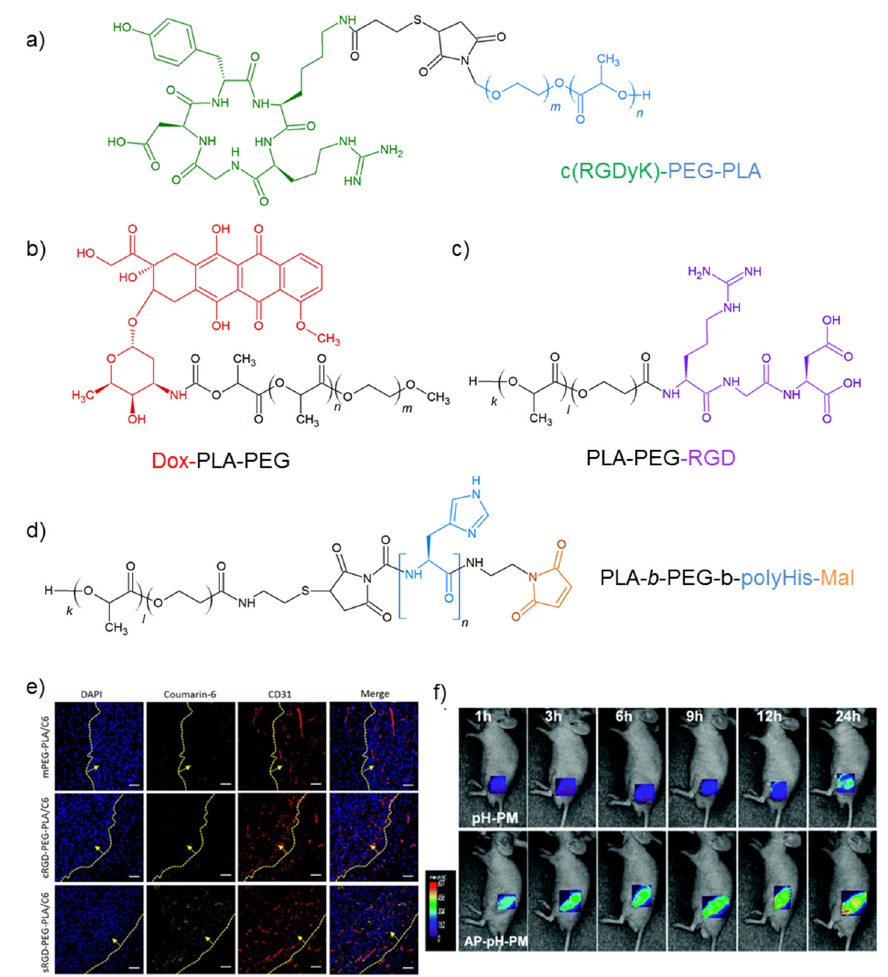
Figure 4. Structures of some PEG-PLGA micelle constituents ( a – d ); ( e ) distribution of different PLA micelles in glioma-bearing brain of nude mice (2 h and scale bar = 50 μ m). The yellow lines are glioma margins, and the arrow points to the side of glioma. Blue, DAPI-marked cell nuclei; green, fluorescein-marked micelles; red, CD31-marked tumor microvessels (reprinted with permission from [78], Copyright 2017 American Chemical Society); ( f ) in vivo fluorescence images of MDA-MB-231 tumor xenografted nude mice treated with TRITC-pH-PM (upper row) and TRITC-AP-pH-PM (lower row) (reprinted with permission from [81], Copyright 2010 American Chemical Society).